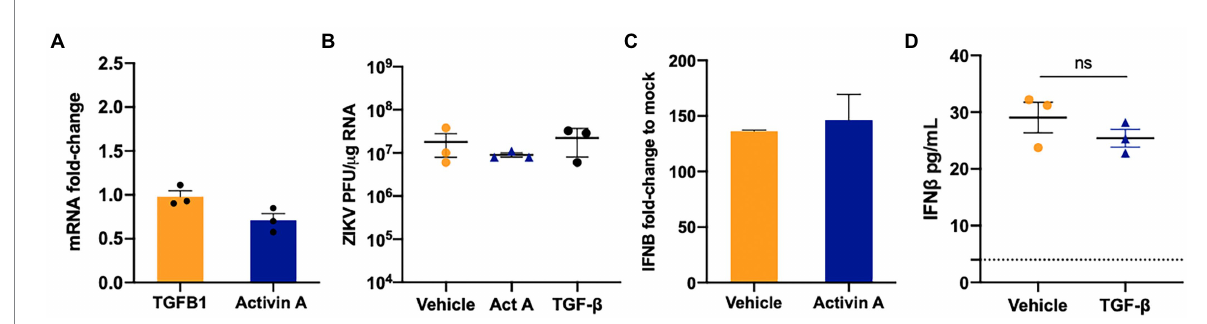
FIGURE 5 TGF- β 1 and Activin do not regulate ZIKV replication in SC. (A) Gene Expression of TGFB1 and INHBA (Activin A) was measured at 48 hpi using qRT- PCR and fold change was calculated as compared to mock-infected cells after normalizing to GAPDH . (B) SC were treated with 15 ng/mL of human recombinant TGF- β 1 protein or 100 ng/mL Activin 24 h before ZIKV infection at MOI 1 and ZIKV PFU equivalents per microgram of RNA were determined at 48 hpi by qRT-PCR. (C) Gene expression of IFNB1 was determined in Activin A exposed SC at 48 hpi using qRT-PCR. (D) Secreted IFN- β protein levels in SC supernatant at 48 hpi was determined by ELISA; the dotted line indicates the minimal detection limit of the assay. Data is presented as mean ± SEM from at least 3–5 independent